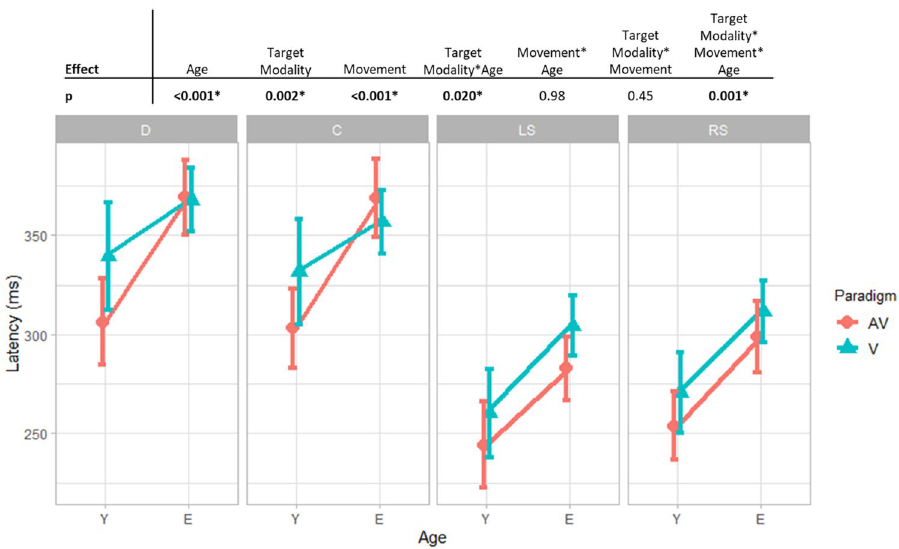
Figure 1. Summary of the main and interaction effects of the 3-way ANOVA with repeated measures for latency. Latency means and 0.95 confident intervals in function of movement (D for divergence, C for convergence, LS for left saccade, RS for right saccade), age group (Y for young group, E for elderly group) and modality target (AV for audiovisual target, V for visual target).